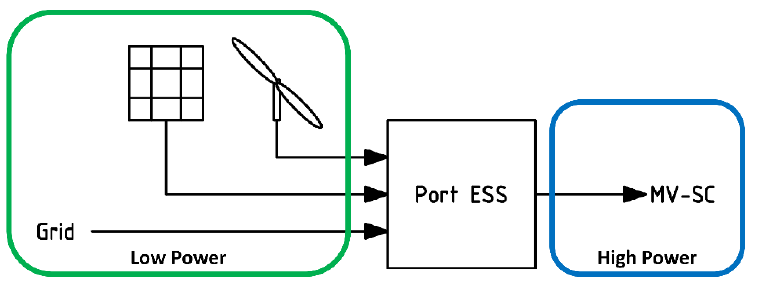
Figure 9. Integration among ESS, renewable sources, grid and MV-SC; third approach.